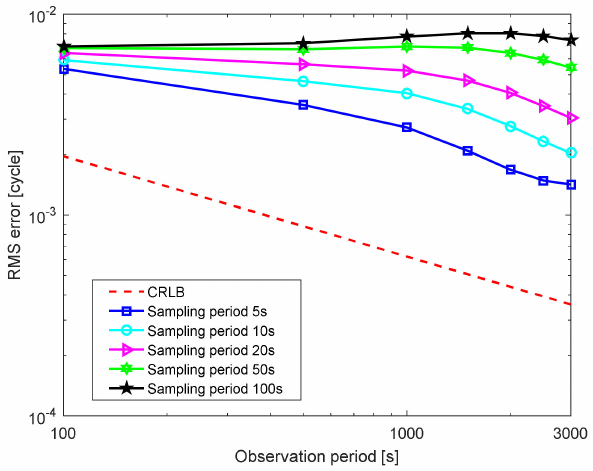
Figure 9. Pulse phase estimation results with different sampling periods of the stellar